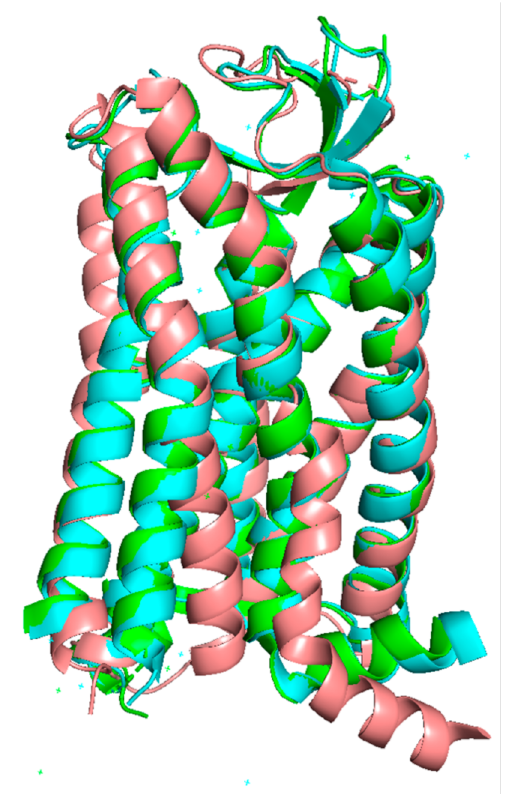
Figure 4. Superimposition of the three known structures of AT 1 . Inactive (salmon), canonical active (green) and alternative active (cyan). TM6 and TM7 are located in the front. In the inactive structure, TM6 is remarkably bent inside the receptor, while TM7 is slightly twisted outside. The reference inactive structure of AT 1 has been chosen as PDB code 4YAY (from [99]). Canonical active and alternative active structures have been chosen as PDB code 6OS0 and 6OS1 respectively (from [96]). The figure was prepared with the PyMOL software (The PyMOL Molecular Graphics System, Version 2.5.0. Schrödinger,